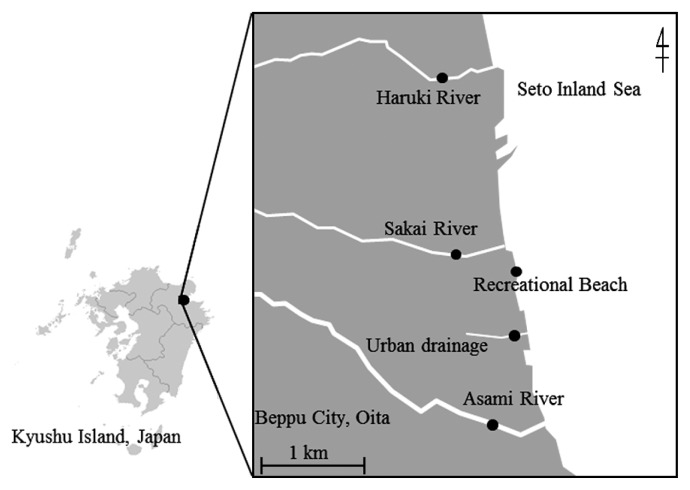
Sampling stations.